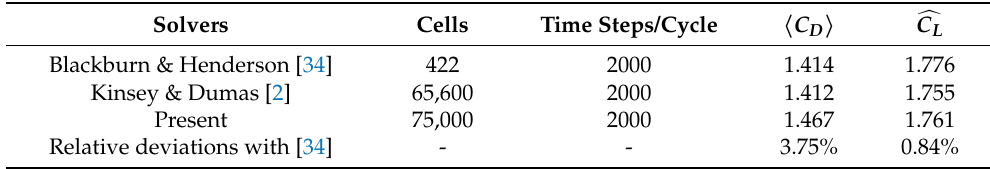
Table 2. Comparison of mean drag coefficient heaving cylinder obtained with the spectral element method [34] and CFD code predictions [2], for Re = 500, f ∗ = 0.228, and h 0 / D =